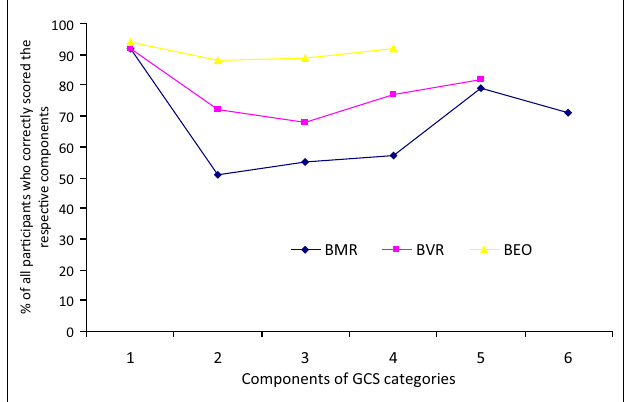
university hospital: distribution of study